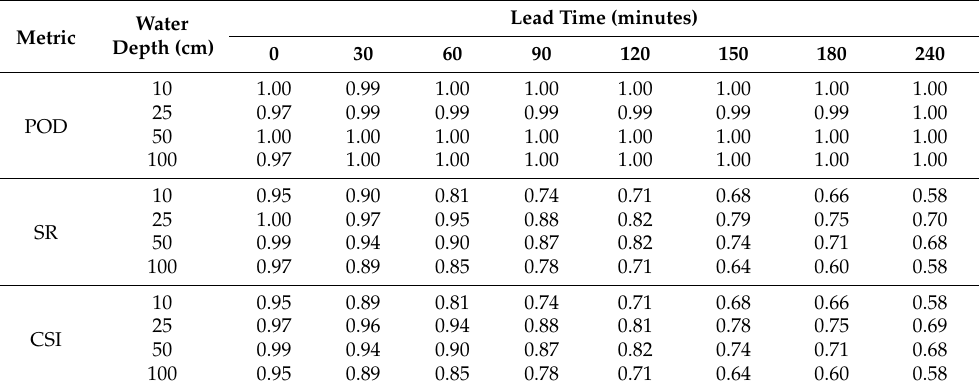
Table 4. Contingency metrics at different lead times for the POI